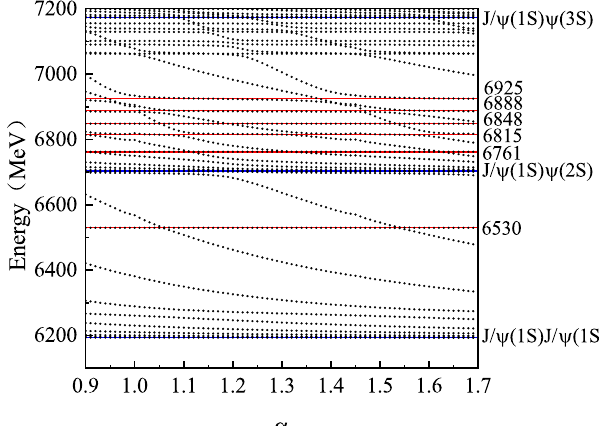
Figure 8. The stabilization plots for the energies of the states for J PC = 0 ++ obtained by considering the coupling between all hidden-color channels and the color-singlet channel ( J / ψ J / ψ ) 0 with respect to the scaling factor α